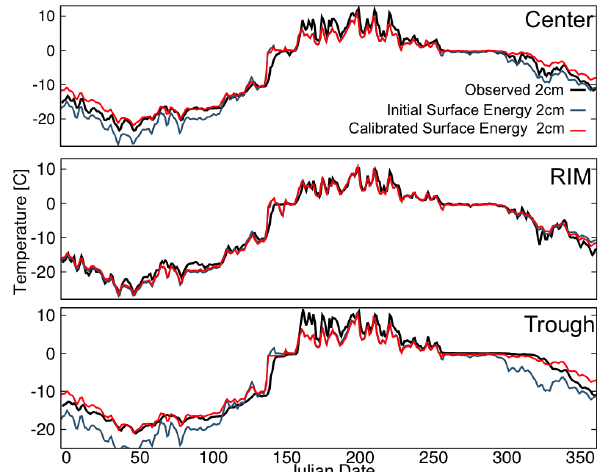
Figure 9. Temperature profiles for a 2cm depth are shown for the center (a) , rim (b) and trough (c) , using the initial surface energy balance parameters (blue), calibrated surface energy balance (red) and measured soil temperature profile (black). The biggest differ- ence between initial temperature profiles and the calibrated profiles is the wintertime temperature for each column, and is a result of distributing snow on the center, rim and trough and depth hoar rep- resentation. Snow distribution also had the greatest control in the ALT (Table